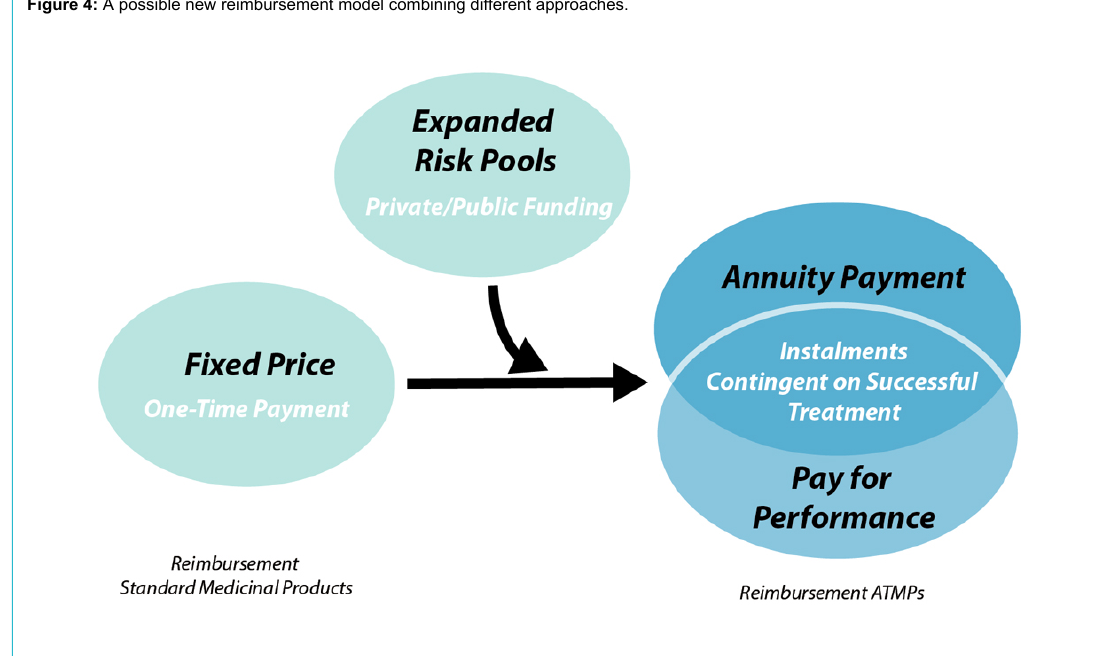
Figure 4: A possible new reimbursement model combining different